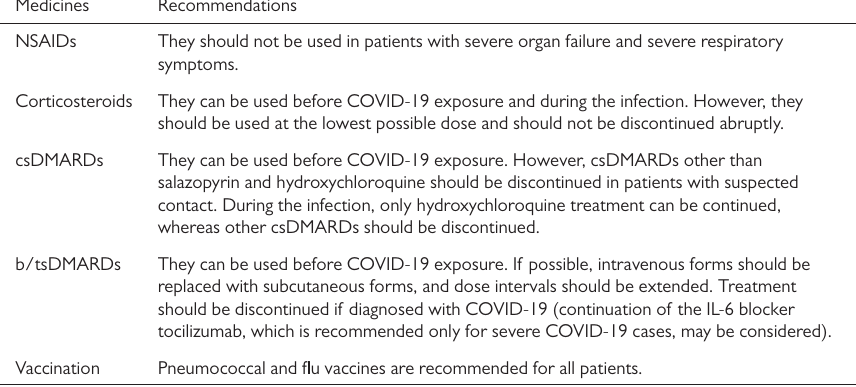
Table 2. Recommendations for the Management of Patients with PsA during the COVID-19 Pandemic